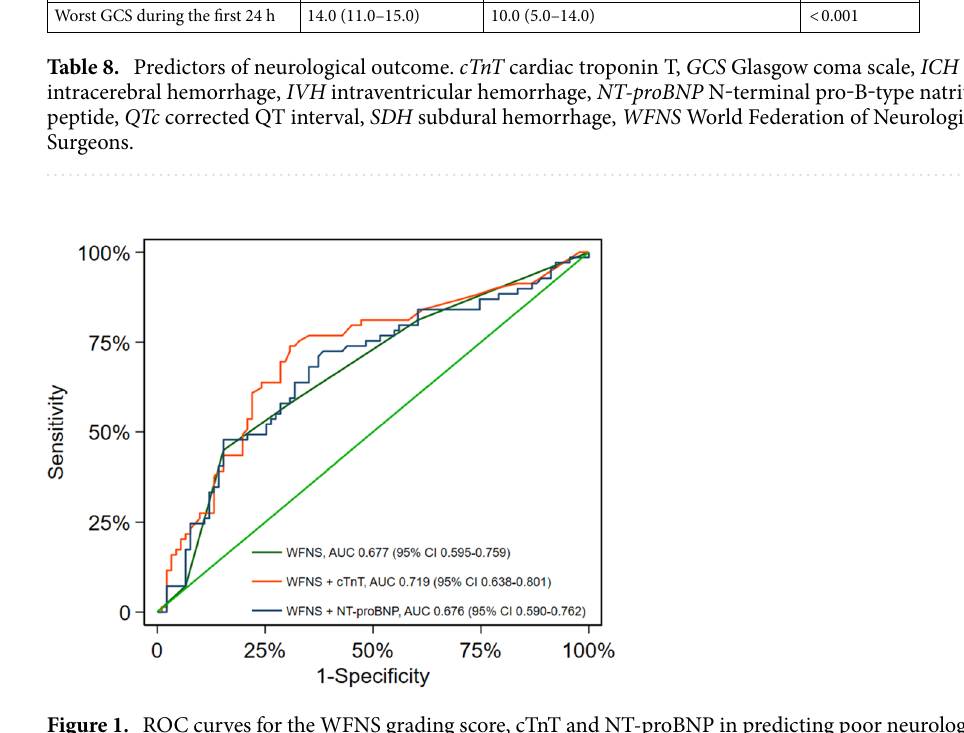
Figure 1. ROC curves for the WFNS grading score, cTnT and NT-proBNP in predicting poor neurological